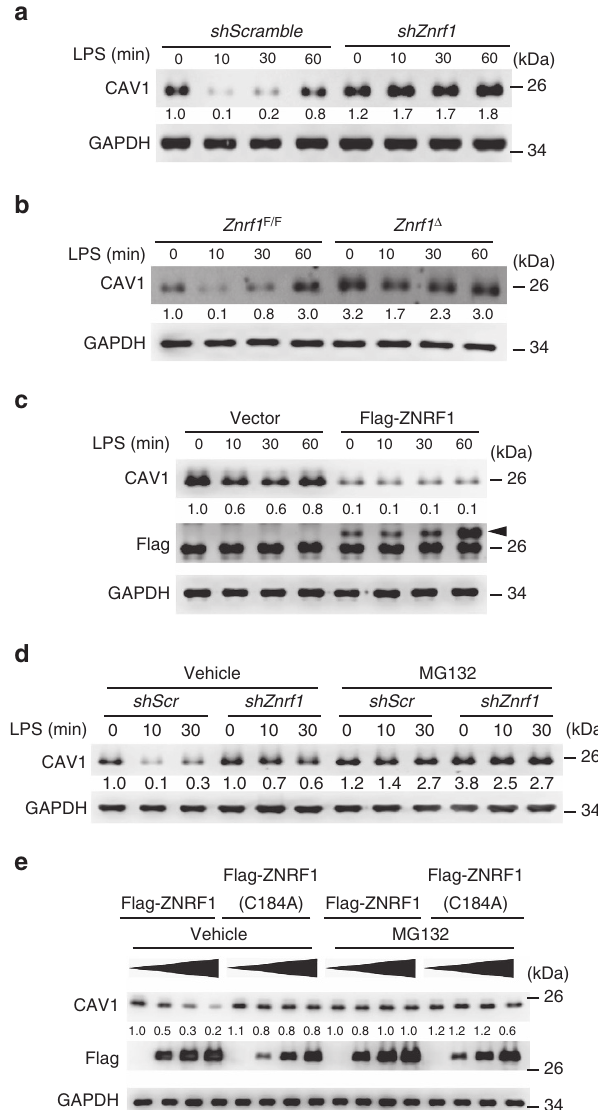
Figure 3 | ZNRF1 regulates CAV1 protein stability. ( a ) Immunoblot analysis of CAV1 and GAPDH in lysates of control (scrambled shRNA) and ZNRF1-shRNA-expressing RAW264.7 cells stimulated with LPS (100ngml (cid:2) 1 ) for the indicated times. ( b ) Immunoblot analysis of CAV1 and GAPDH in lysates of Znrf1 F/F and Znrf1 D cells treated with LPS (100ngml (cid:2) 1 ) for the indicated times. ( c ) Immunoblot analysis of the indicated proteins in lysates of control (vector) and Flag-tagged ZNRF1-expressing RAW264.7 macrophages stimulated with LPS (100ngml (cid:2) 1 ). The arrow indicates Flag-ZNRF1. ( d ) Immunoblot analysis of CAV1 protein in lysates of scrambled control and Znrf1 -knock-down RAW264.7 cells stimulated with 100ngml (cid:2) 1 LPS with or without pretreatment with MG132 (10 m M). ( e ) HEK293T cells were transfected with increasing amounts of Flag-tagged wild-type ZNRF1 or ZNRF1(C184A); 24h after transfection, the cells were treated with MG132 (10 m M) for at least 6h, and cell lysates were analysed by immunoblotting with the indicated antibodies. The intensities of the bands are expressed as fold increases compared to those of untreated control cells after normalization to GAPDH expression. The data are representative of three independent experiments performed in